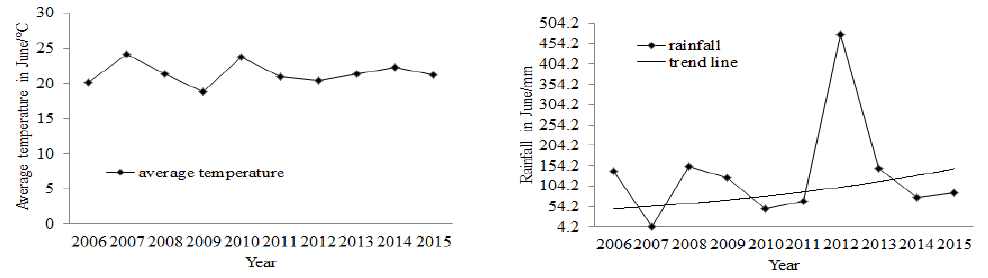
Figure 5. Average temperature and precipitation in June of Changchun from 2006 to